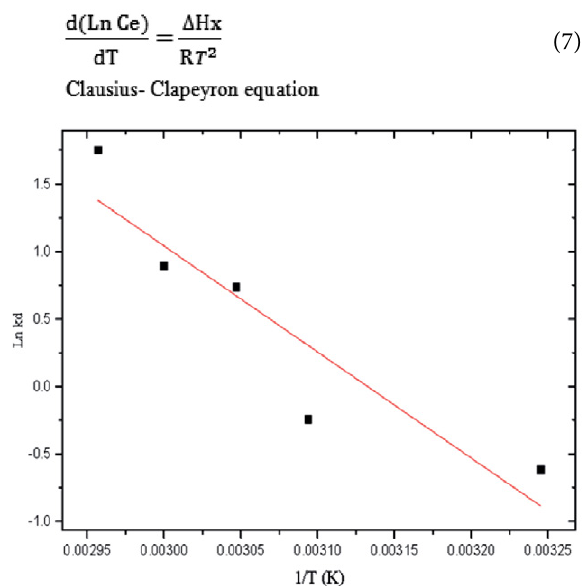
Figure 15. Ln k vs temperature for calculation of thermodynamic properties.